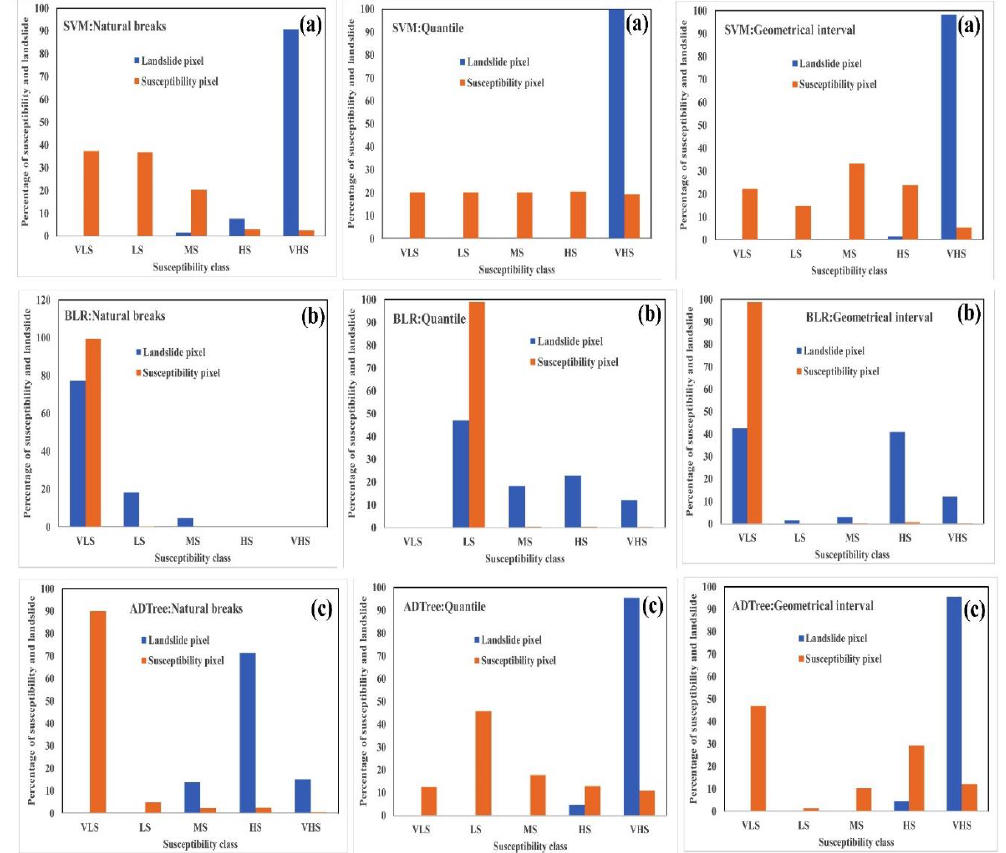
Figure 5. Histograms used to prepare the landslide susceptibility maps for three classification methods (natural break, quantile, and geometrical interval): ( a ) SVM, ( b ) BLR, ( c ) ADTree.